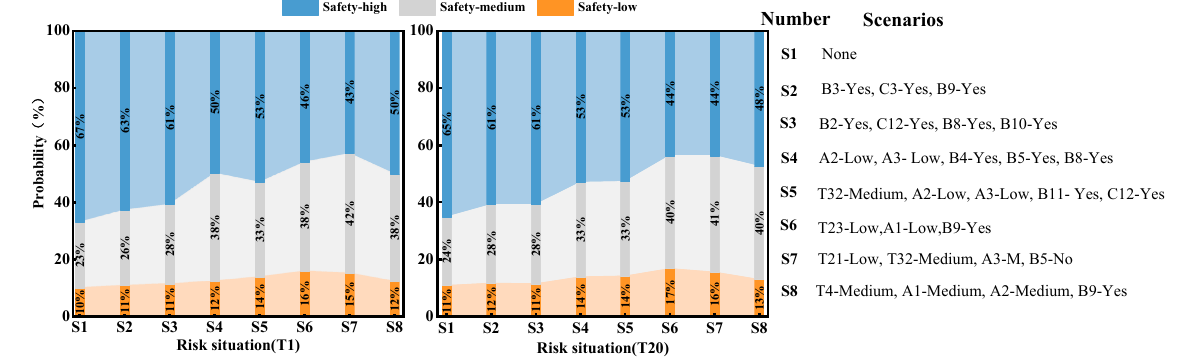
Figure 13. Percentage values for the safety of construction of DFPs adjacent to existing underpass tunnels in eight scenarios.